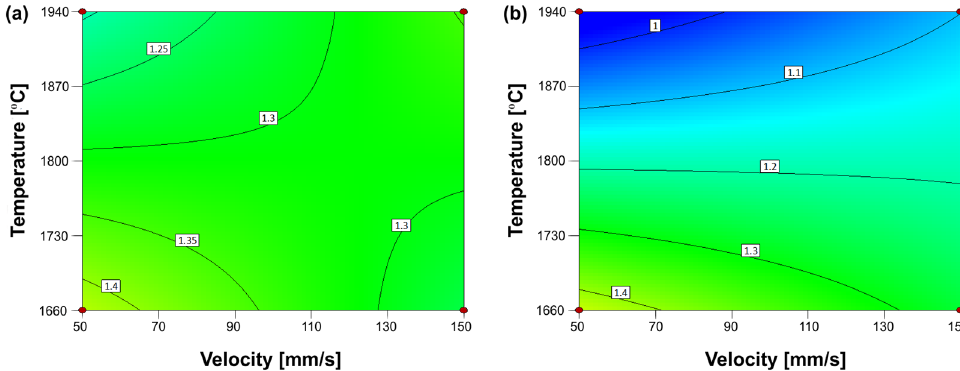
Figure 9. Process maps (speed vs. temperature) based on the first DoE waviness model according to Equation (4) for laser polishing for ( a ) small laser spot of 0.6 mm and an overlap of 90% and ( b ) a larger laser spot size of 0.9 mm and an overlap of 90%.